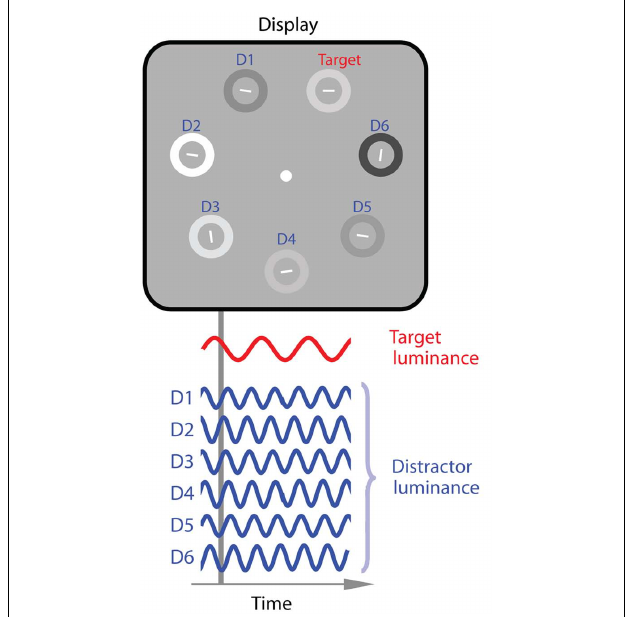
FIGURE 1 | Illustration of an example search display. In Experiment 1 all distractor annuli modulated with an identical frequency within a given trial (1.3 or 12.1Hz) whilst target annuli modulated at either 1.3, 2.7, 4.0, 6.7, 8.1, or